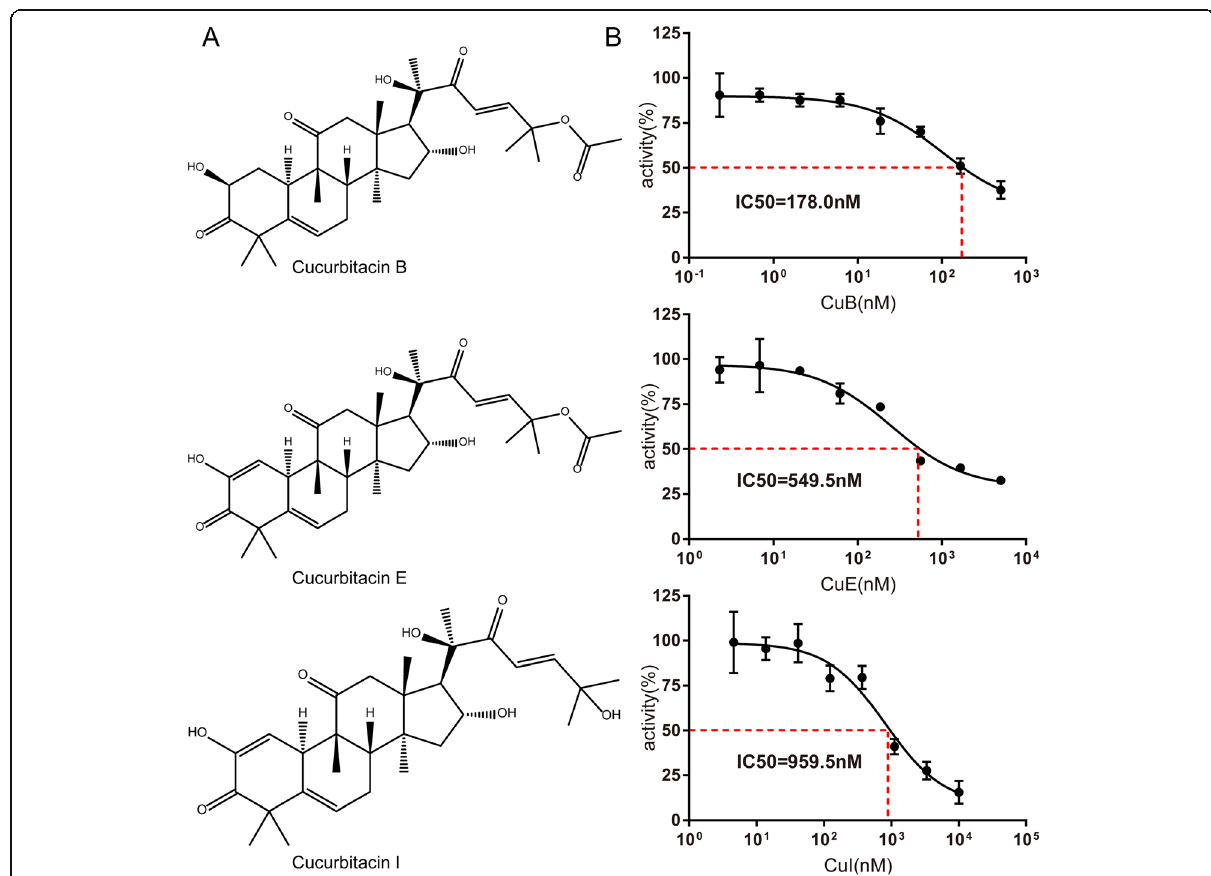
Fig. 1 Cucurbitacins inhibit Tropomyosin receptor kinase A (TrkA) kinase activity at the cellular level . (a ) Chemical structure of cucurbitacin B (CuB), CuE, and CuI. ( b ) TrkA activity in the presence or absence of increasing concentrations of CuB, CuE, and CuI. The results are presented as the percentage of kinase activity relative to the control (dimethyl sulfoxide), and the average of at least duplicate reactions, in which similar results were